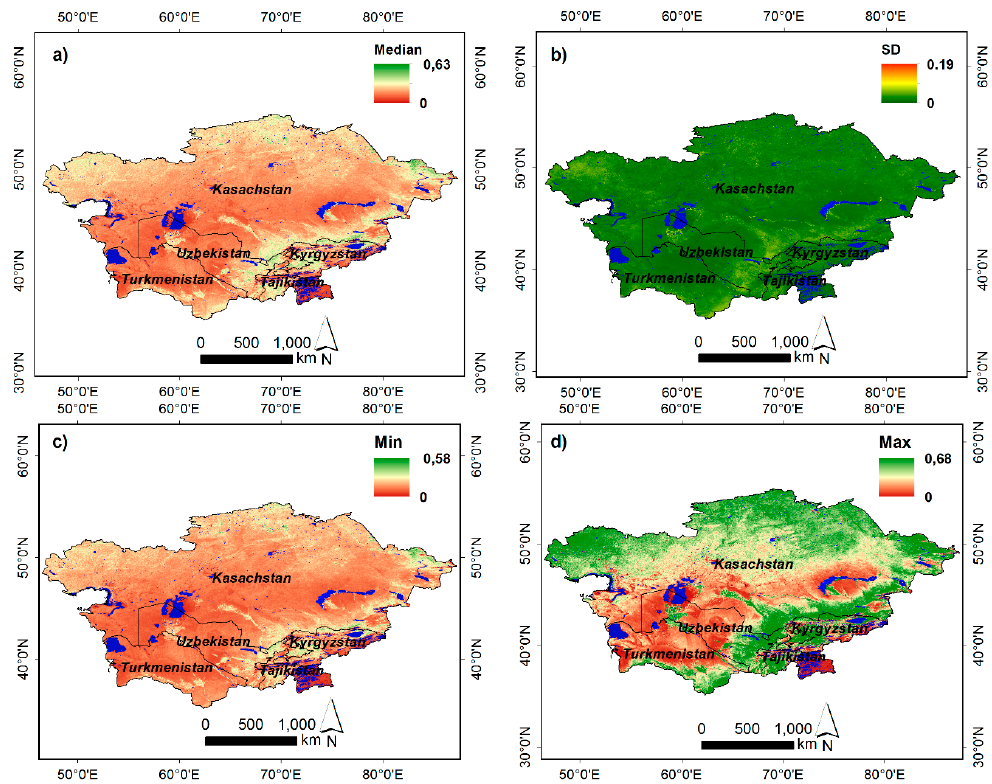
Figure 2. Spatially explicit descriptive statistics of overall greenness across post-Soviet Central Asia.